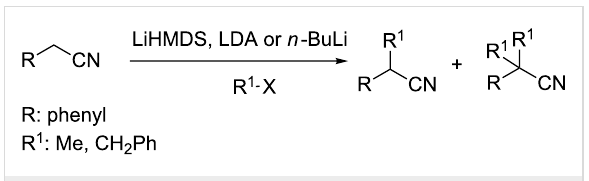
Figure 1: Synthesis of mono- or dialkylated